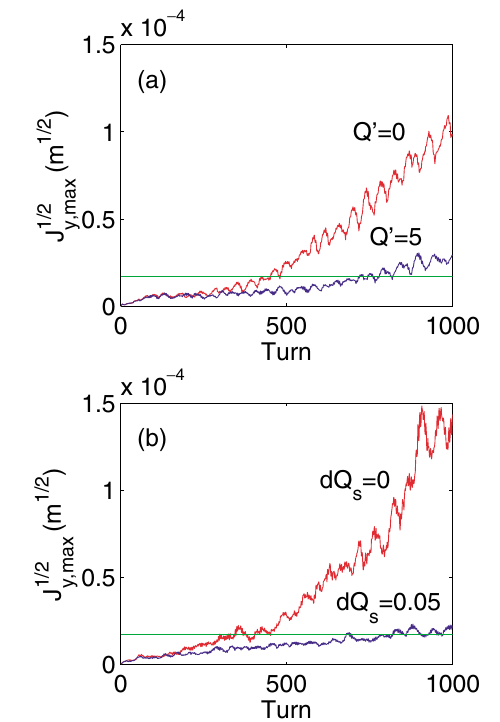
FIG. 7. (Color) Dependence on chromaticity and synchrotron tune spread. (a) depicts the evolution of J (cid:4) 0 , and (b) depicts those for (cid:15) Q Q 0 p The horizontal green line indicates (cid:3)(cid:3)(cid:3)(cid:3)(cid:3) "